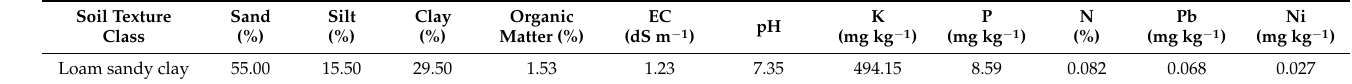
Table 1. The physico-chemical characteristics of the soil used for the